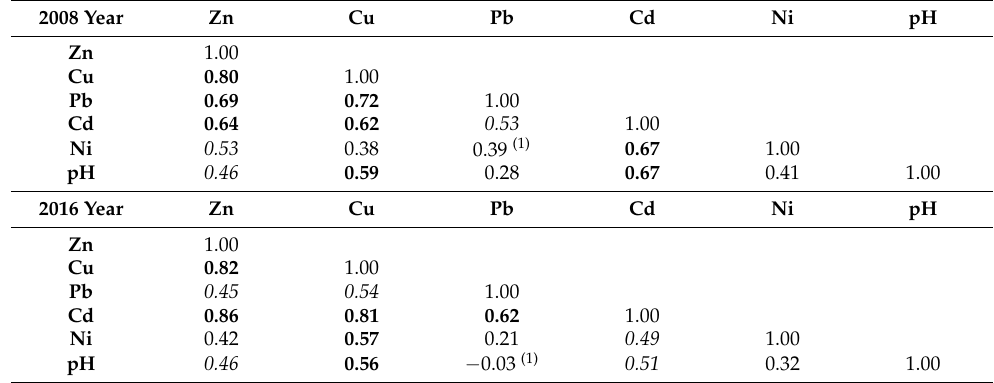
Table 4. Pearson’s and Spearman’s correlation coefficients of metal mobile fractions (in 2008 and